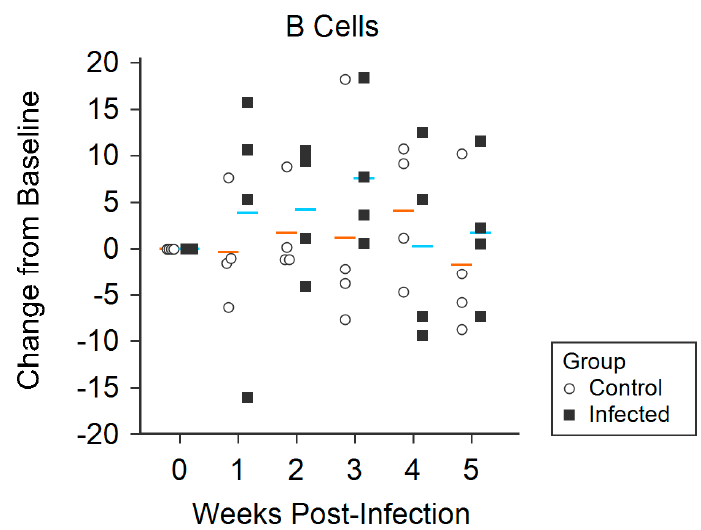
Figure 6. Trends of measured B cells over the course of the study period, reported as the change in percentage of cells from initial pre-infection measurement (standardized to 0 on the y-axis); horizontal lines indicate the mean change in percentage for each group, where blue represents that of infected animals and orange represents that of control animals.